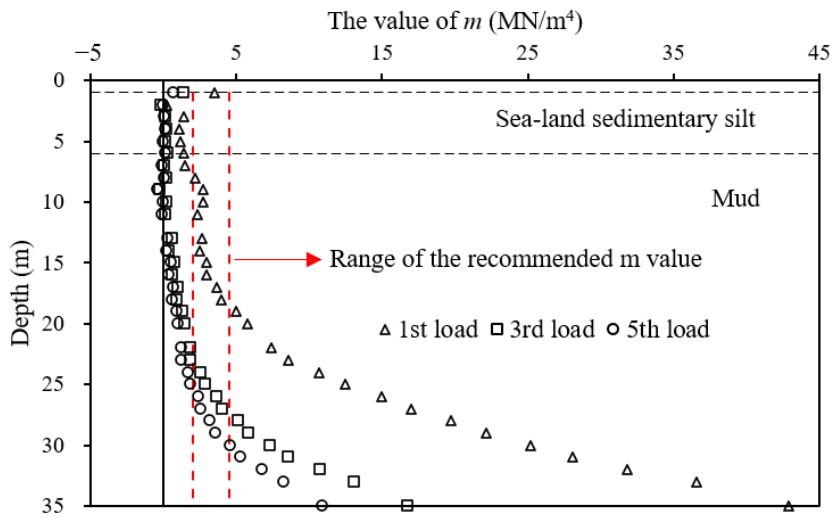
Figure 12. The distribution of the m value along the depth after the 1st, 3rd, and 5th